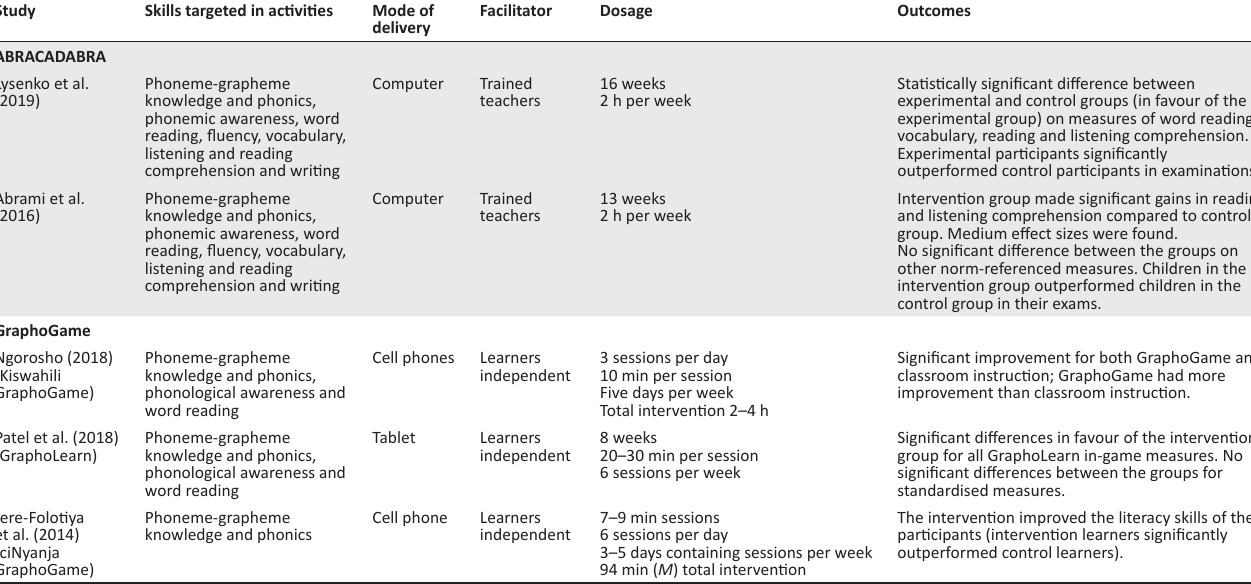
TABLE 3: Information and communication technology studies carried out in the majority world – Summary of interventions in the scoping review.